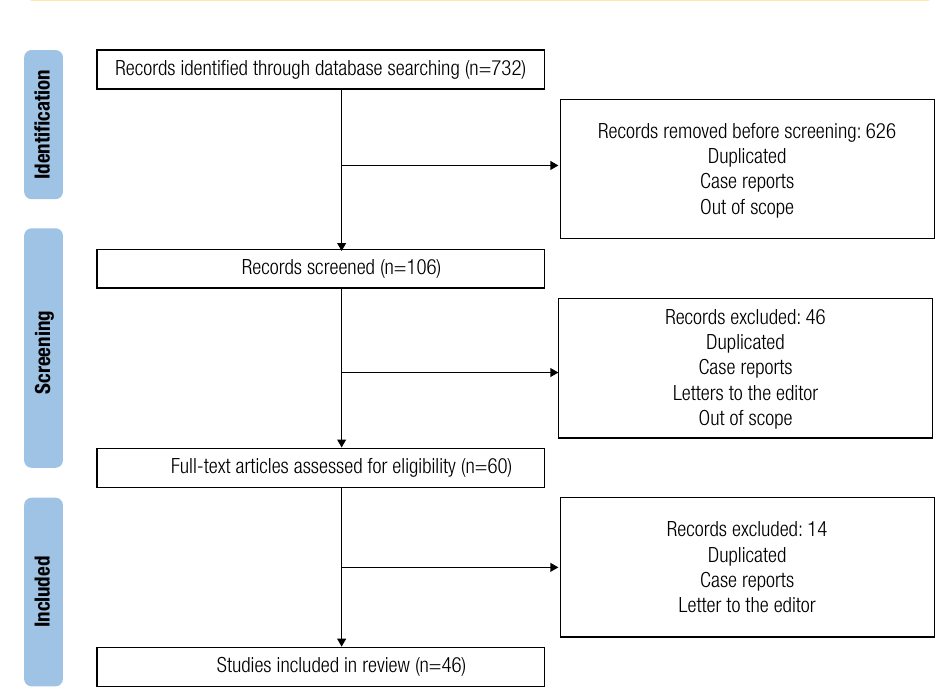
Figure 1. Prisma flow